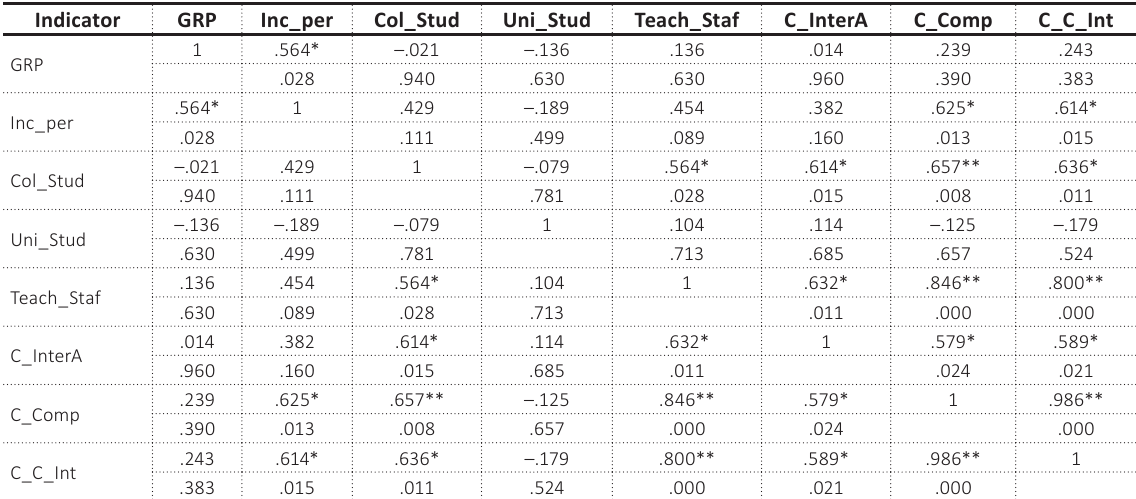
Table 6. Spearman’s rho Correlation matrix – 2020 / Sig. (2-tailed)